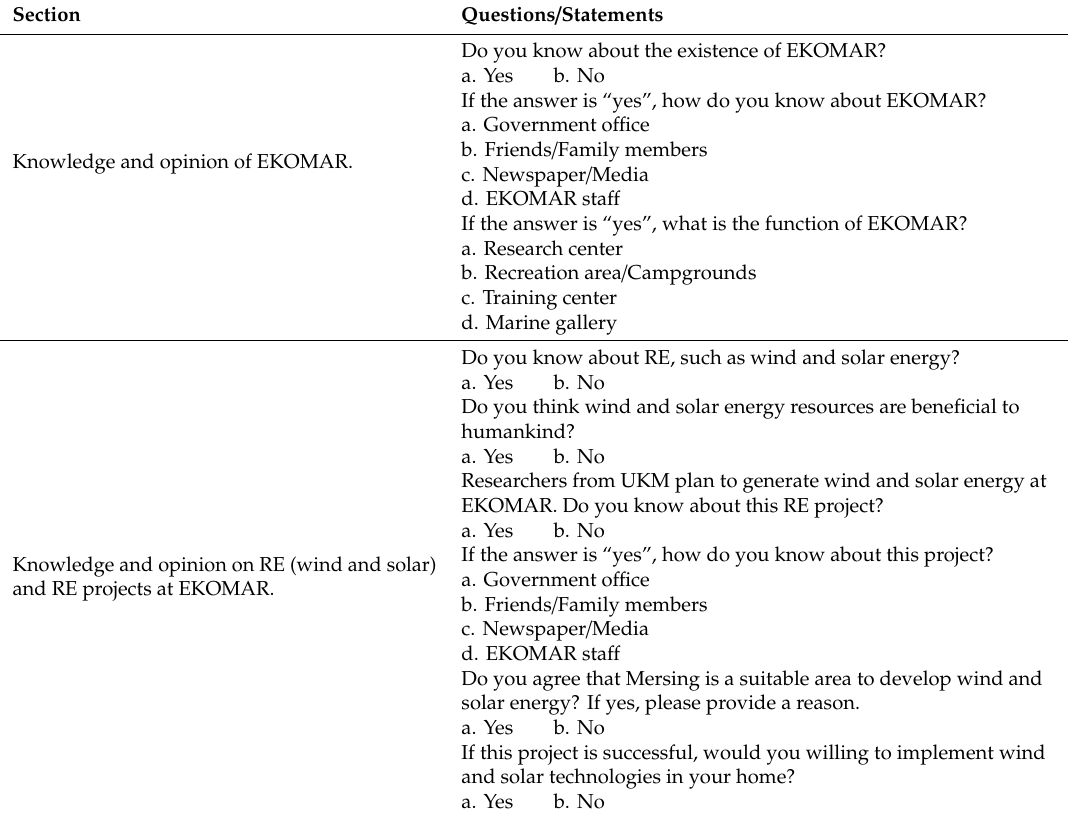
Table 2. Questions for first survey (prior to EKOMAR project